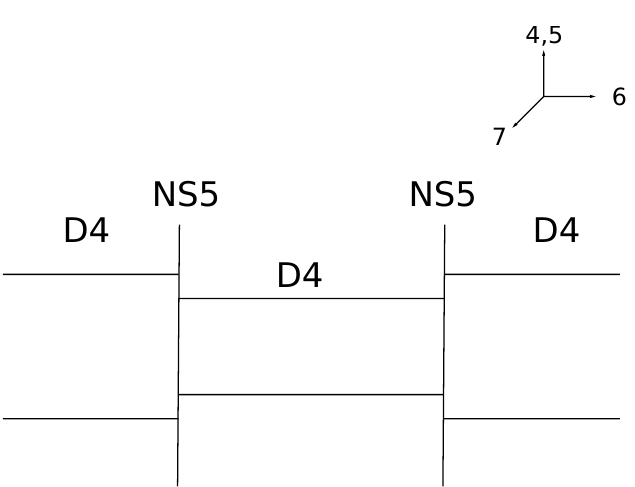
Figure 3 . A brane construction for SU(2) with N f = 4 , where all the four semi-infinite D4-branes end on two NS5-branes in pairs. This brane construction corresponds to the symmetric set up discussed in section